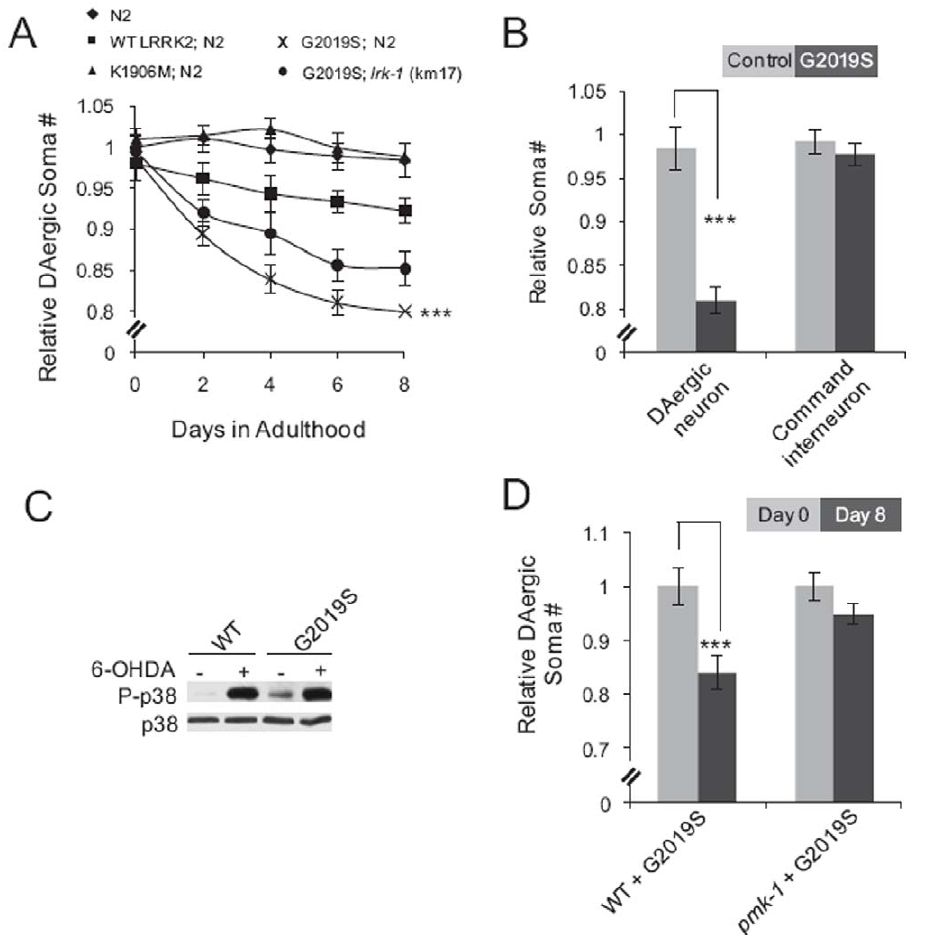
Figure 6. Expression of human pathogenic G2019S mutant LRRK2 in nematodes leads to ageing-associated DAergic-specific neurodegeneration and chronic p38 activation. ( A ) Quantification of DAergic neurons as a function of nematode age demonstrates that G2019S expression in nematodes elicited LRRK2 kinase-dependent DAergic neuron degeneration. Nematode variants were N2 nematodes (diamonds), N2 nematodes expressing K1906M LRRK2 (triangles), WT LRRK2 (squares), or G2019S LRRK2 (crosses) and lrk-1 mutant nematodes ( km17 ) expressing G2019S LRRK2 (circles). The number of DAergic somas was normalized to the mean number of DAergic somas observed in N2 L4 nematodes throughout the study as described in Experimental Procedures. Data represent the mean 6 SEM of four independent experiments. Each experiment employed 20–30 nematodes. ***, p , 0.005; two-way ANOVA compared N2 nematodes expressing G2019S mutant LRRK2 with N2 nematodes expressing WT LRRK2. ( B ) G2019S-mediated neurodegeneration in nematodes is DAergic-specific. DAergic neuron and command interneuron somas were quantified in day 8 N2 nematodes with (black) or without (grey) pan-neuronal expression of G2019S mutant LRRK2. Somas of DAergic neurons and command interneurons were visualized with P dat-1 driven DsRed or P nmr-1 driven YFP, respectively. Command interneurons were not DAergic. Only AVA and PVC command interneurons were used for this quantification because their fluorescent somas can be unambiguously distinguished from other command interneurons in nematodes due to their position and stronger YFP expression. The numbers of DAergic or command interneuron somas were normalized to the mean number of DAergic or command interneuron somas observed in N2 L4 nematodes, respectively (see Experimental Procedures). Data represent the mean 6 SEM of four (DAergic neuron) or three (command interneuron) independent experiments. 20–30 nematodes were used for each experiment. ***, p , 0.005 by t-test. ( C ) LRRK2 KD cells reconstituted with G2019S LRRK2 have a high basal level of activated p38, but are comparable to cells reconstituted with WT LRRK2 in their response to 6-OHDA. Western blotting was performed using lysates from 3 9 -UTR LRRK2 KD SH-SY5Y cells expressing G2019S mutant LRRK2 (G2019S) or WT LRRK2 (WT). Cells were left untreated or treated with 100 m M 6-OHDA for 4 hours. ( D ) p38 prevents G2019S-mediated adult onset DAergic neurodegeneration in nematodes. DAergic neuron somas were counted in L4 (day 0, grey) or day 8 (black) N2 or pmk-1 mutant nematodes with pan-neuronal G2019S expression. Data was normalized to respective day 0 animals and represent the mean 6 SEM of 3 independent experiments (20–30 nematodes each). ***, p , 0.005 by t- test. doi:10.1371/journal.pone.0022354.g006 expression of G2019S nematodes, but not K1906, LRRK2 led to mutant and a wild type nematode line expressing G2019S p38-dependent neurodegeneration that was reduced in a lrk-1 LRRK2; and another one generated by injecting G2019S LRRK2 mutant background. Consistently, G2019S expression in human construct into lrk-1 mutant nematodes. We found that the blastoma cells activated p38 and chronic p38 activation was transgenic nematode line generated by this cross displayed no previously reported to be cytotoxic in cell lines [56]. It is DAergic neurodegeneration (Figure 6A) while the transgenic interesting that we examined two lrk-1 mutant nematode lines nematode line generated by injection showed some DAergic expressing G2019S, one generated from the genetic cross of a lrk-1 neurodegeneration (Figure 1A). The amount of G2019S LRRK2